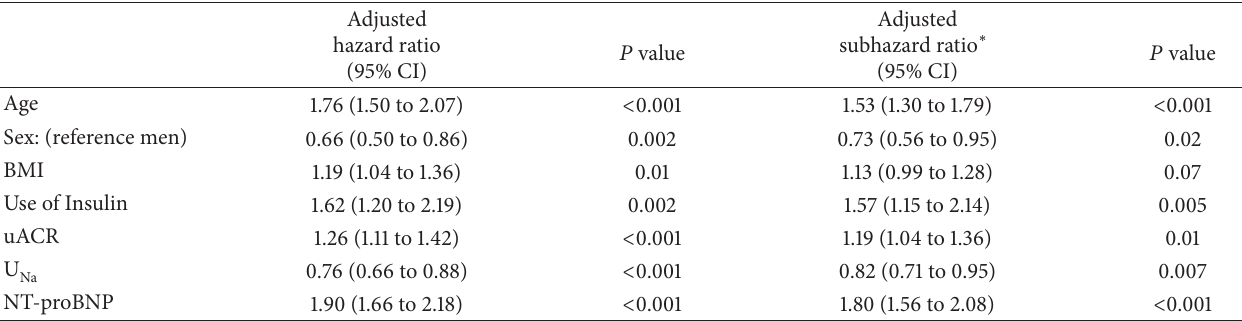
Table 6: Risk of cardiovascular death according to Cox model [ left ] and Fine and Gray competing risk [ right ]